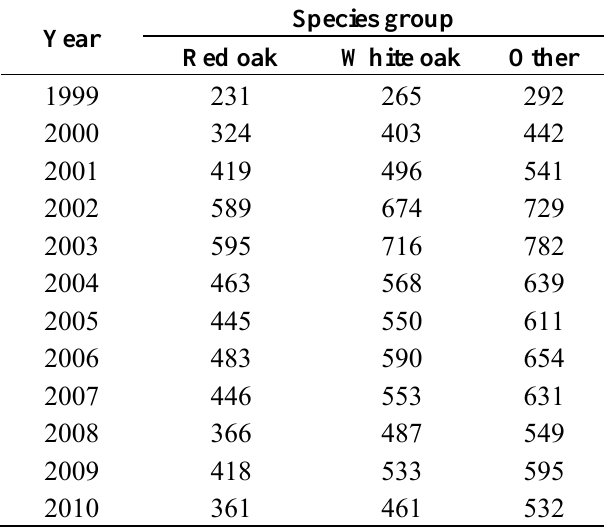
Table 1. Number of plots within each species group used in analysis. Species group Year Red oak White